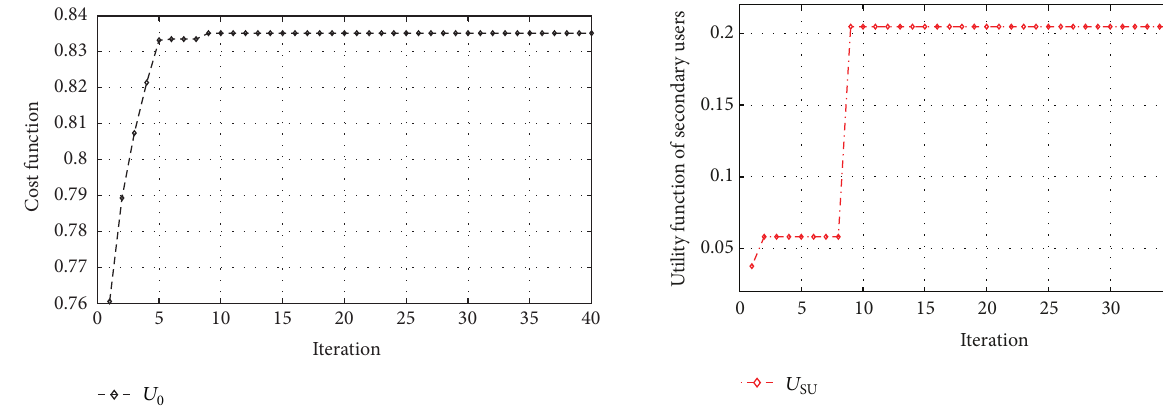
Figure 3: Behavior of the main cost function.